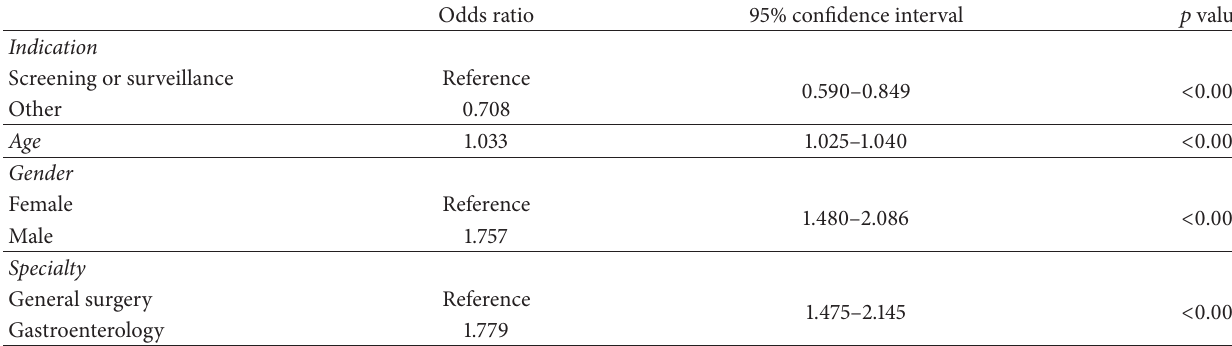
Table 5: Multivariable logistic regression model for adenoma